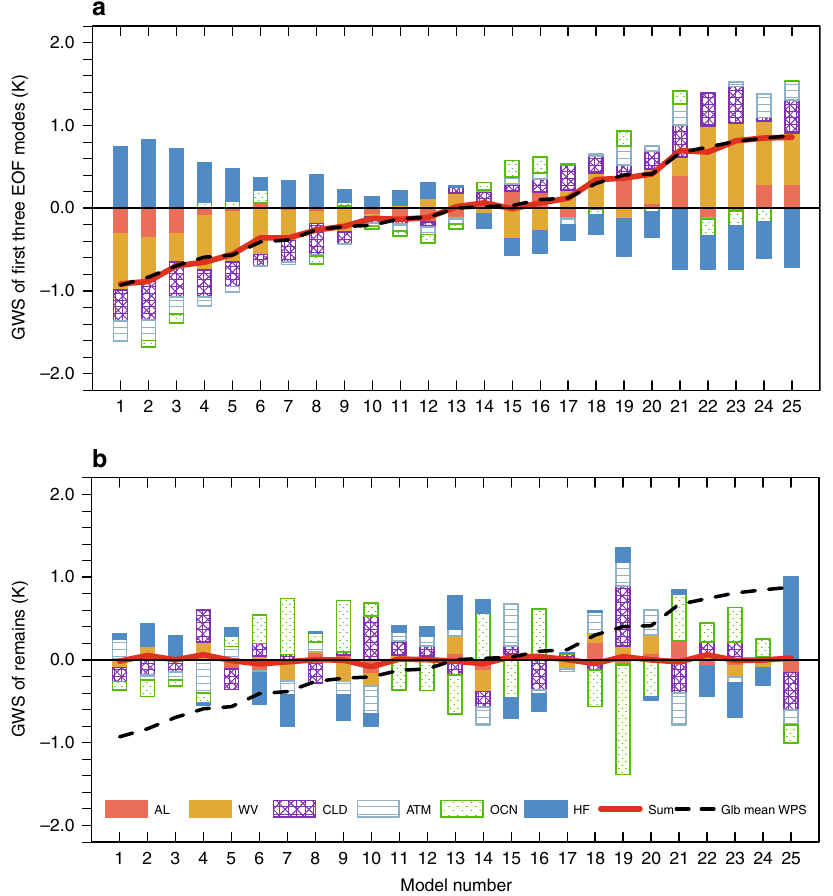
Fig. 5 Stacked bar chart of the inter-model spreads of partial temperature changes. a Global means of partial temperature changes shown in Fig. 1e – j ( K ; ordinate) as a function of model number (abscissa) captured by the fi rst three EOF (empirical orthogonal function) modes and b the same as a but for the remaining fi elds. Different feedback processes are represented by different colors using the color scheme on the bottom. The solid red line corresponds to the (vertical) sum of the stacked color bars and the dashed black line corresponds to the global mean of individual models ’ temperature changes shown in Fig. 1c, namely, the global warming spread (GWS), or the global (glb) mean of warming pattern spread (WPS). Models are in the order of their projected global-mean surface warming from the smallest to the largest. The abbreviations AL, WV, CLD, ATM, OCN, and HF (f) stand for processes of ice-albedo, water vapor, clouds, atmospheric dynamics, ocean dynamics plus heat storage, and surface turbulent heat fl uxes,